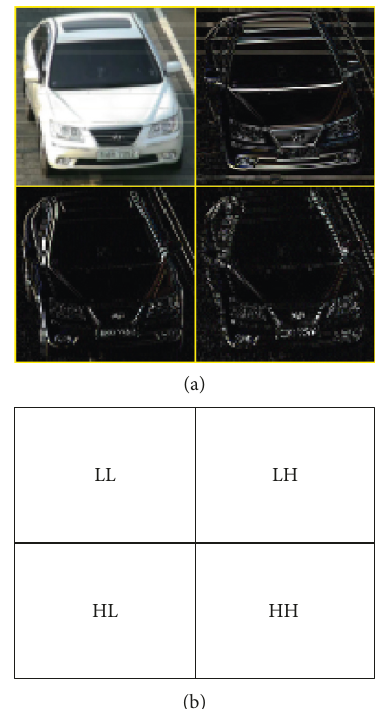
Figure 5: (a) First level of DWT. (b) Subbands of the first level of DWT.